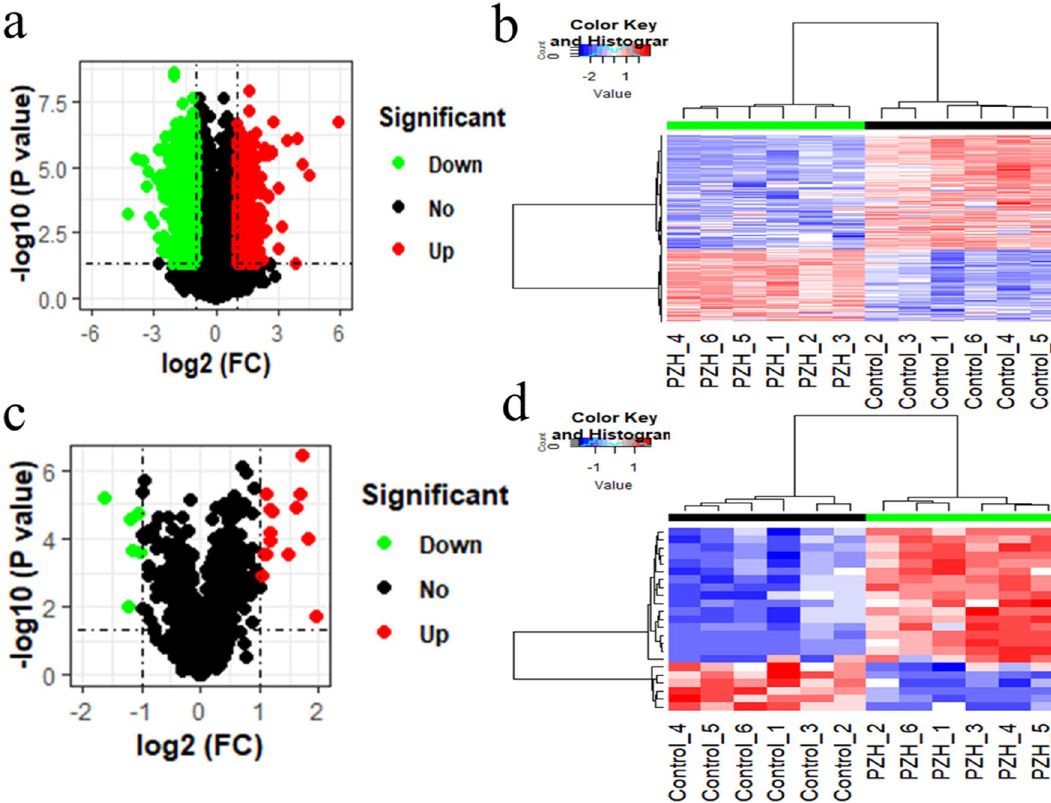
Figure 4. Visualization of the differentially expressed transcripts. ( a ) Volcano plot displays the differentially expressed protein-coding transcripts. ( b ) Heat map displays the expression level of differentially expressed protein-coding transcripts. ( c ) Volcano plot displays the differentially expressed lncRNA transcripts. ( d ) Heat map displays the expression of differentially expressed lncRNA transcripts. The red dots represent upregulated transcripts while green dots indicate downregulated transcripts in volcano plot. Red indicates high expression level while blue represents low expression level in the heat map. Heat maps of ( b ) and ( d ) were created using